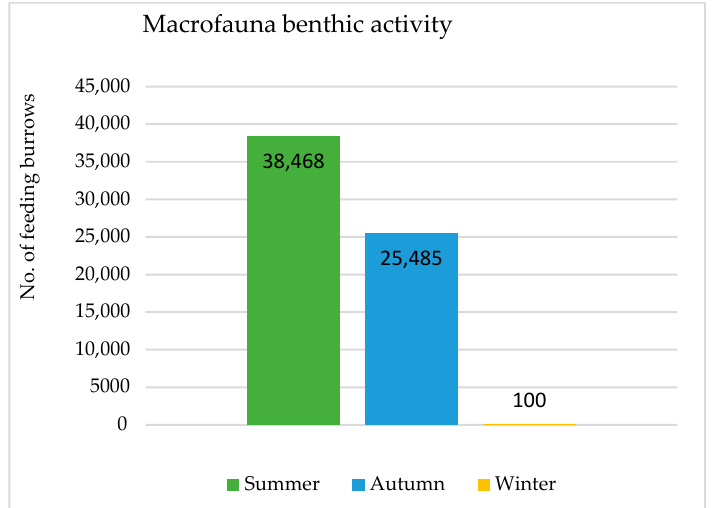
Figure 6. Graph showing macrofauna benthic activity from their feeding burrows from the time-series seasonal imagery.